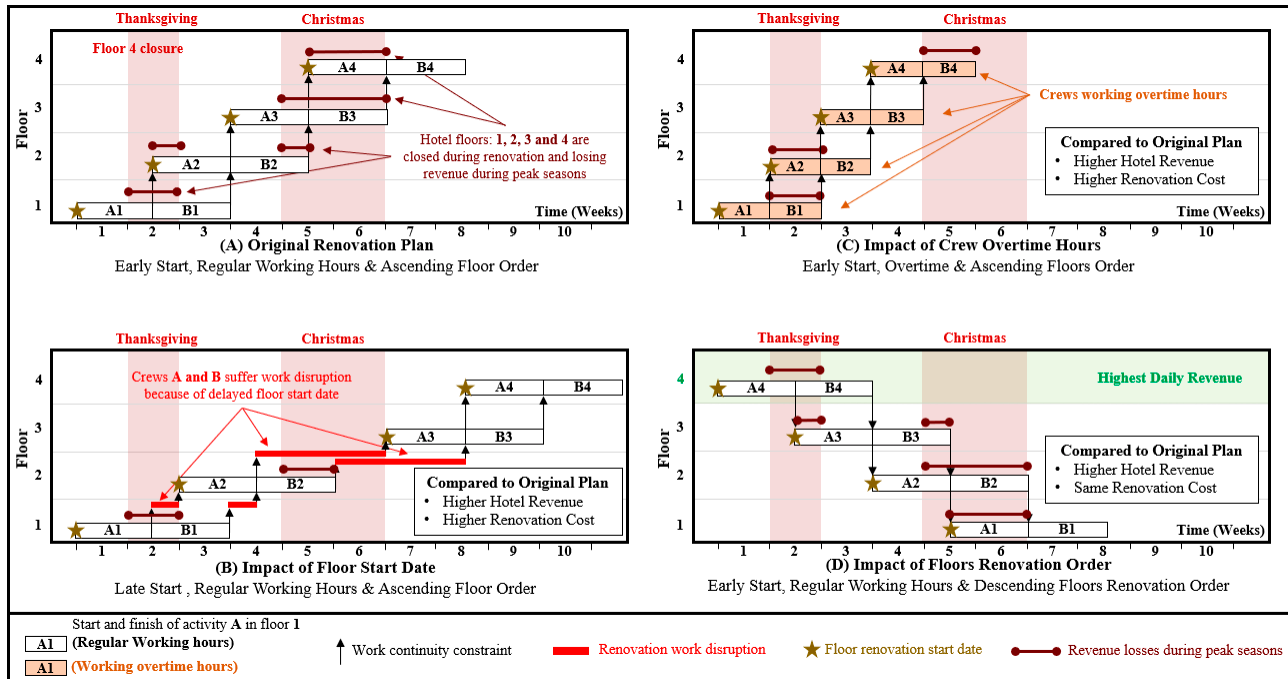
Figure 1. Impact of renovation planning decisions on hotel revenue and cost.